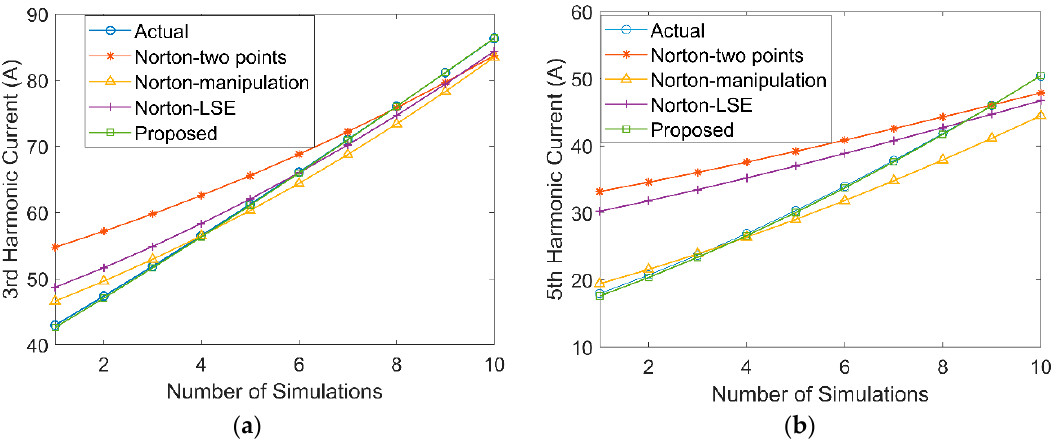
Figure 5. Three components of estimated harmonic current, that is, Y + , Y − and I 0 respectively. Three components of one 3rd harmonic current vector estimation ( a ) and three components for estimated harmonic current in orders from 3 to 25 ( b ).